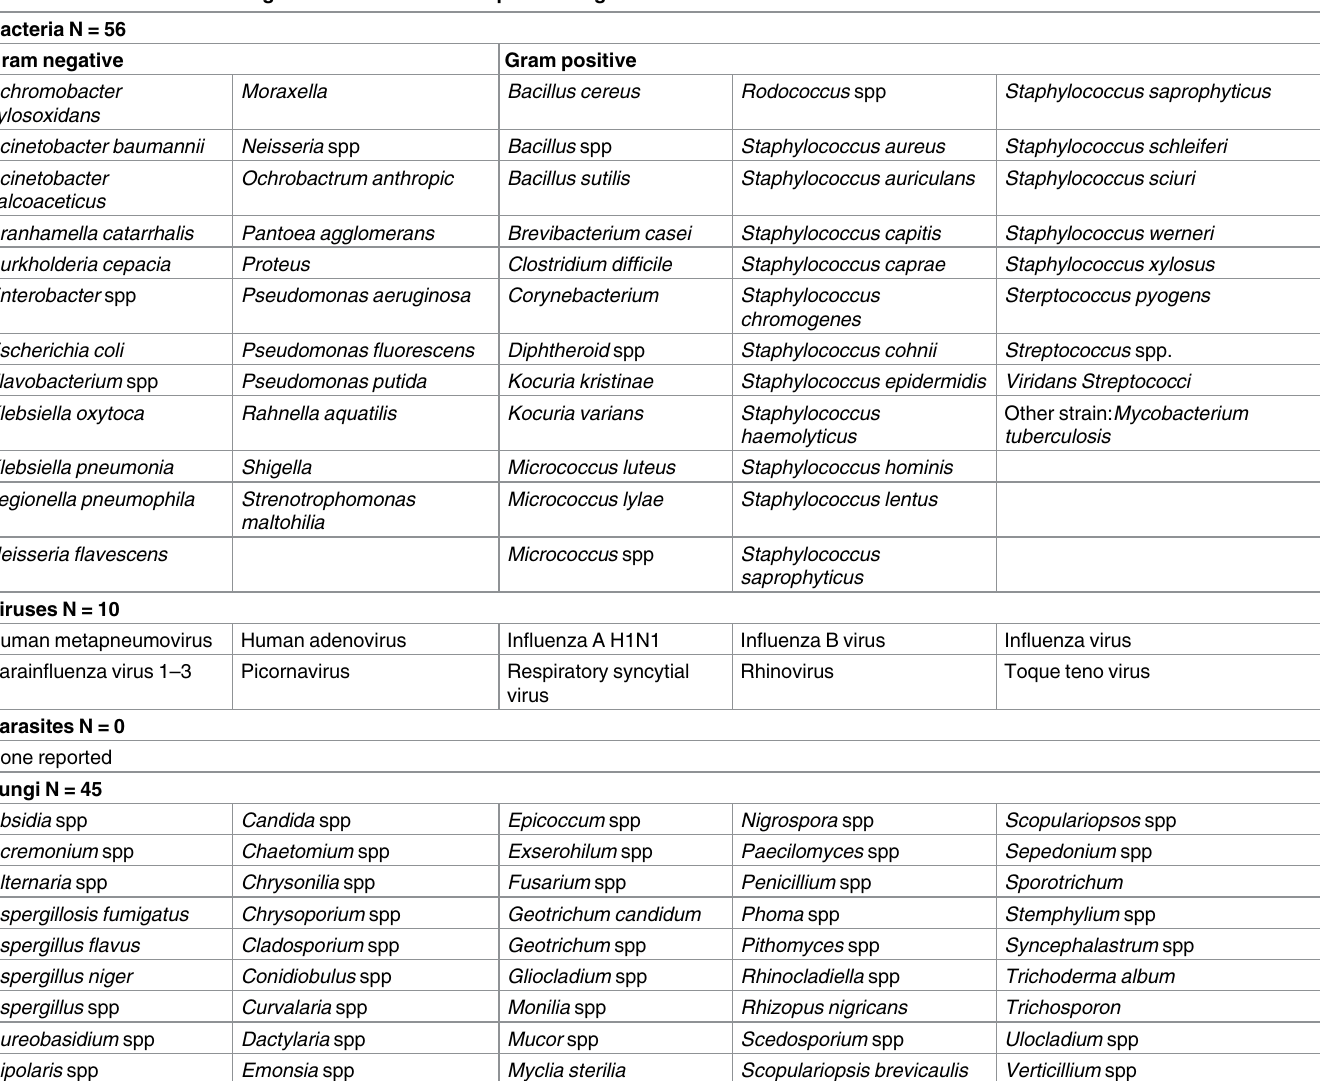
Table 1. Overview of micro-organisms identified in hospital